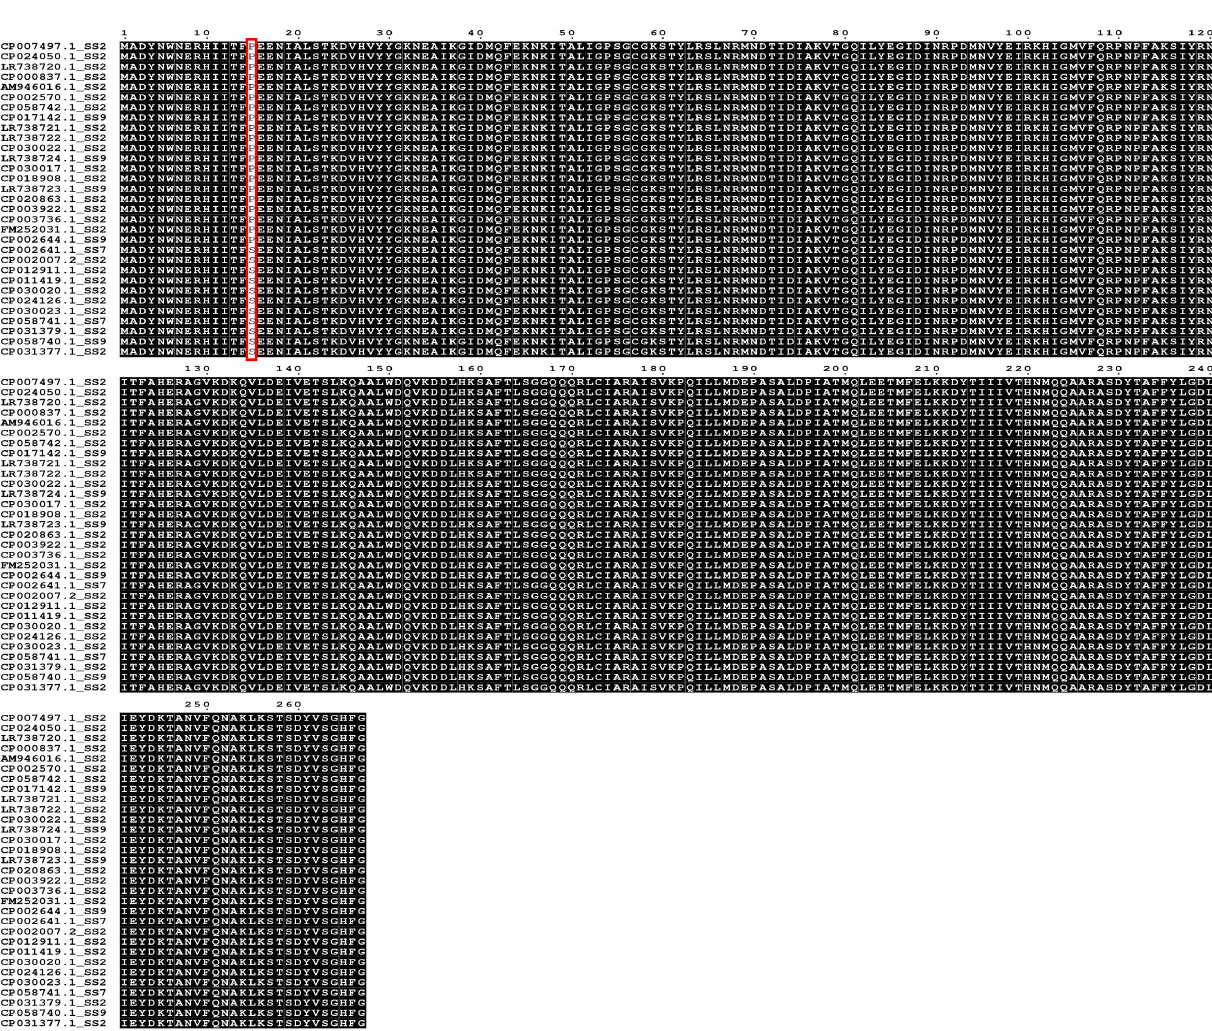
Figure 1. Sequence alignment and PCR screening of PstB in different S. suis strains. ( A ) The PCR results of pstB gene screening in 18 S. suis isolates. Lane 1, Serotype 2. Lane 2, Serotype 7. Lane 3, Serotype 9. Lane 4–18, S. suis strains randomly selected from clinical isolates. ( B ) Amino acid sequence alignment of PstB from S. suis strains collected from the GenBank database. The amino acid mutation position is marked with a red